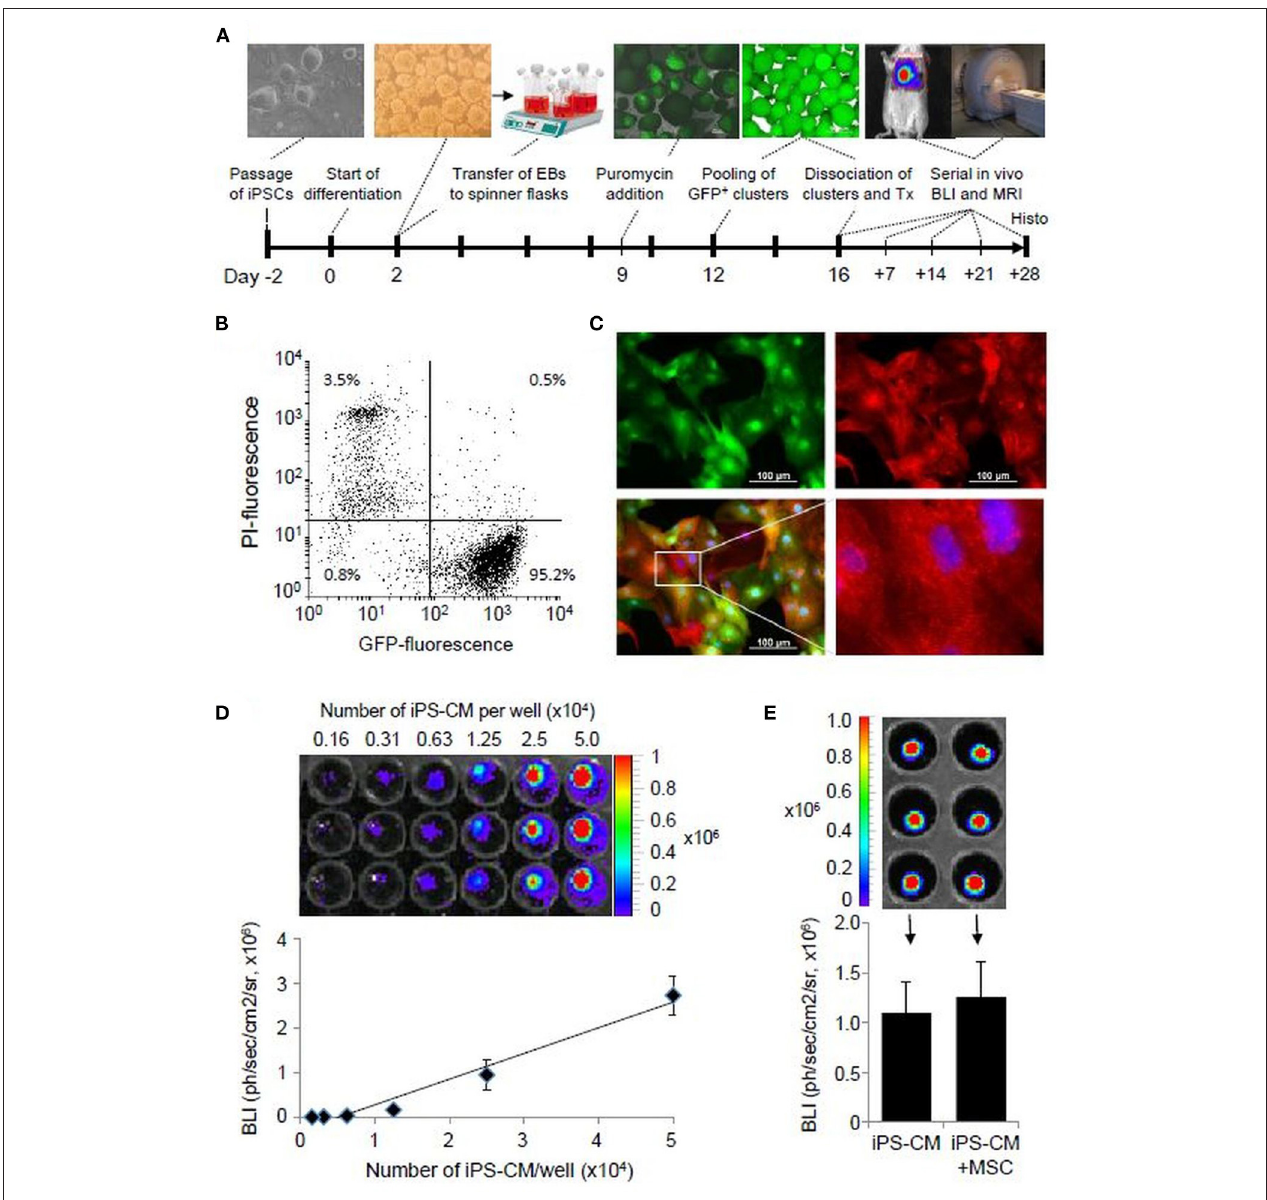
FIGURE 1 | iPS-CM characterization. (A) Schematic diagram of cardiac iPSC differentiation and experimental plan. (B) Flow cytometric analysis of eGFP-positive puromycin selected FLuc- α PIG-iPS-CM at day 16 of differentiation (2 x 10 4 events). PI-propidium iodide. (C) Immunofluorescence detection of eGFP (green) and α -actinin (red) in purified iPS-CM plated on fibronectin-coated dishes. Nuclei were stained with Hoechst. (D) Optical signal intensity of serial dilutions of 5.0 x 10 4 iPS-CM expressing FLuc was measured in IVIS. The image in the upper panel shows a representative result of one serial dilution in triplicates. The lower panel demonstrates the linearity between cell dose and BLI of iPS-CM shown in the upper panel. The data are given as mean ± SD. (E) Determination of the BLI signal of 10 4 /well FLuc- α PIG-iPS-CM alone or mixed with the same number of MSC in IVIS. Data in the bar graph are shown as mean ± SD of two different batches of iPS-CM and MSC each measured in triplicates as shown in the representative IVIS image in the upper panel. The statistical significance of differences in groups was checked by the unpaired student’s t -test. IPSC, induced pluripotent stem cells; eGFP, enhanced green fluorescent protein; CM,